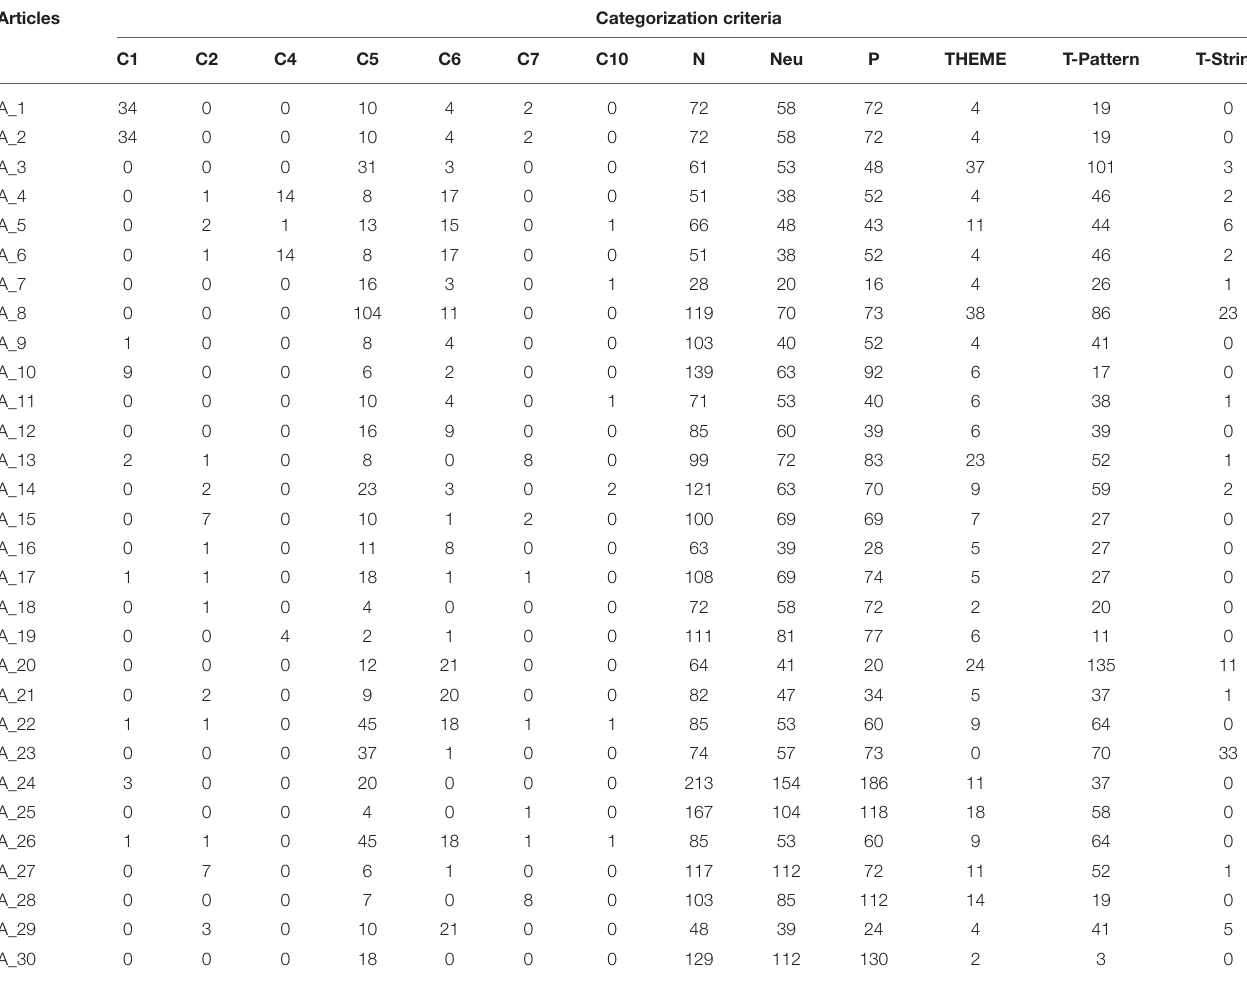
TABLE 4 | Analysis of document-coding criteria co-occurrence.